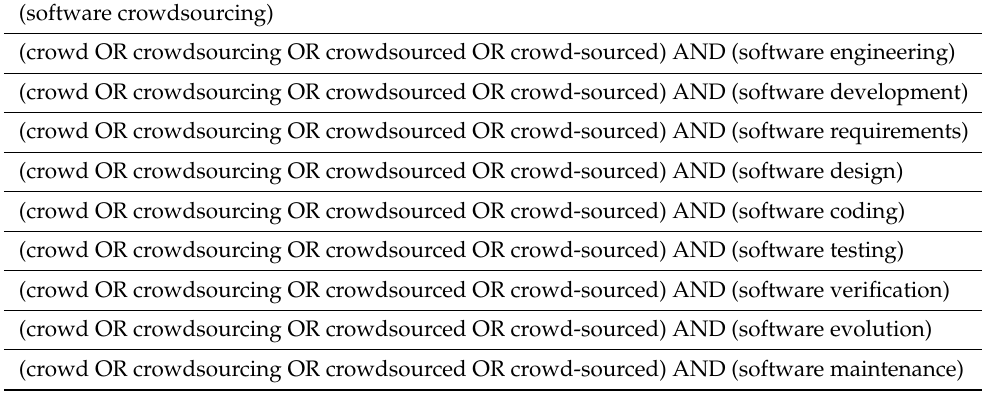
Table 1. Search terms.